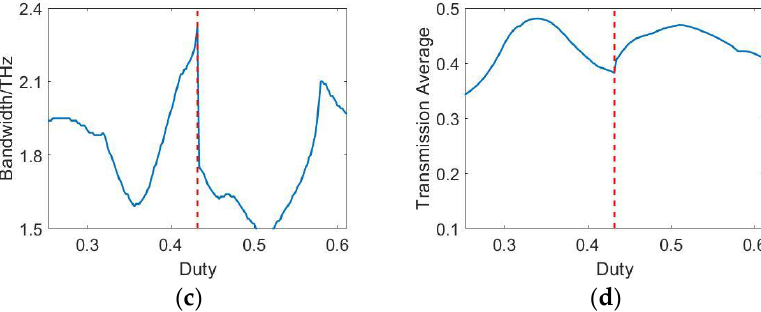
Figure 4. Effect of duty ratio variation on filter performance: ( a ) and ( b ) show the effect diagram and the filter transmission spectrum; ( c ) and ( d ) are graphs of the 3-dB bandwidth and the average transmission efficiency with different duty ratios.